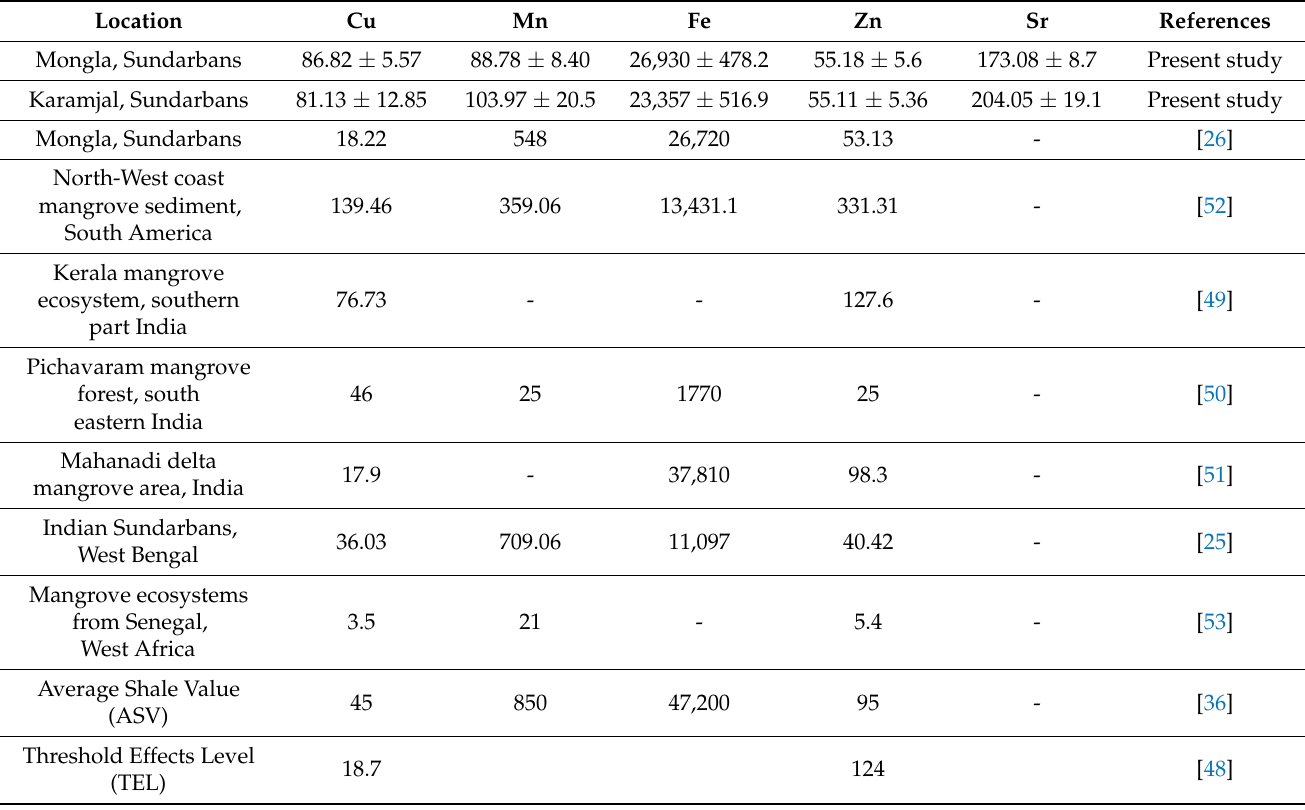
Table 1. The average concentrations of common trace elements (mg/kg) in the sediment of present study and selective mangrove wetlands around the world.